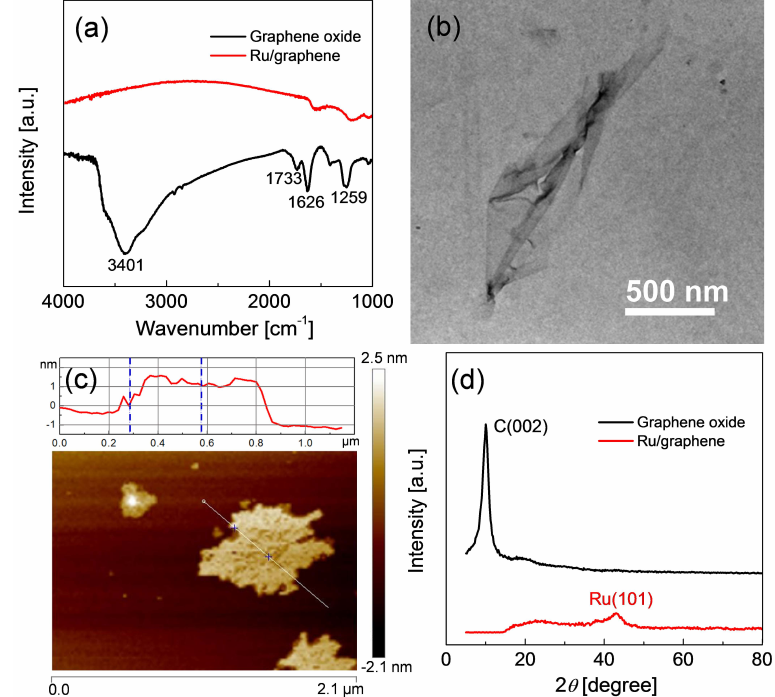
Figure 2. ( a ) FT-IR of graphene oxide and Ru/graphene nanocomposites; ( b ) TEM image of graphene oxide; ( c ) AFM image and height profile of a graphene oxide sheet; and ( d ) PXRD diffraction patterns of graphene oxide and Ru/graphene nanocomposites.